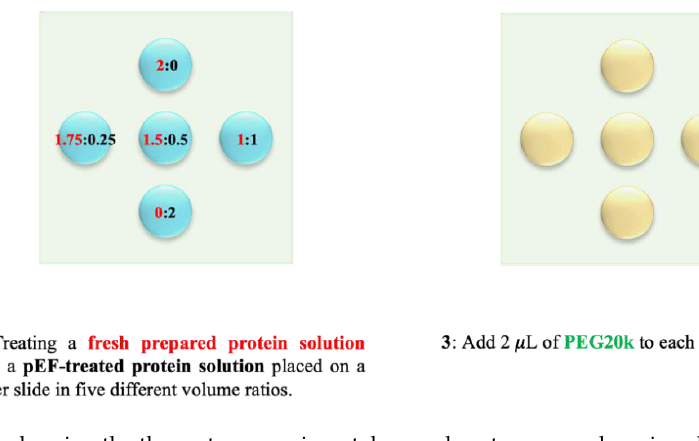
Figure 3. Scheme showing the three-step experimental procedure to prepare hanging-drop crystal- lization droplets of GI with varying volume ratios of mesoscopic ordered clusters, prior prepared by treating a protein solution with a pEF.